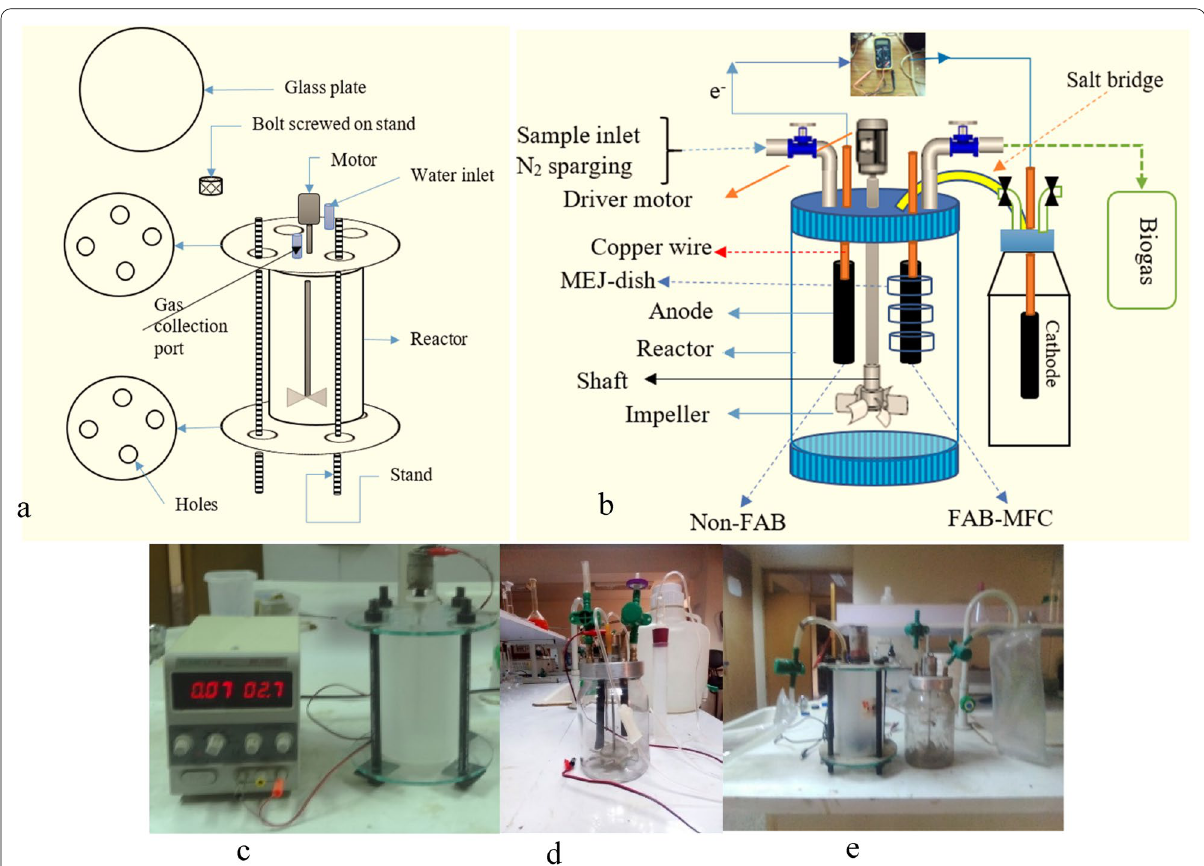
Fig. 2 Schematic diagram a , b and photo c , d , e bench-scale FAB-microbial fuel cell (FAB-MFC) of anode a , c , cathode d , and combined setup b ,